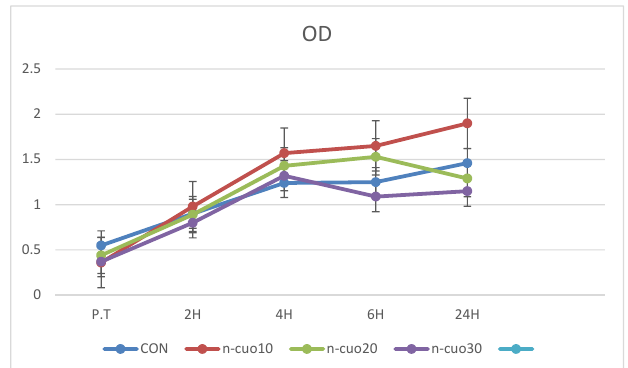
components of PCR are shown in Tables 2 and 3,